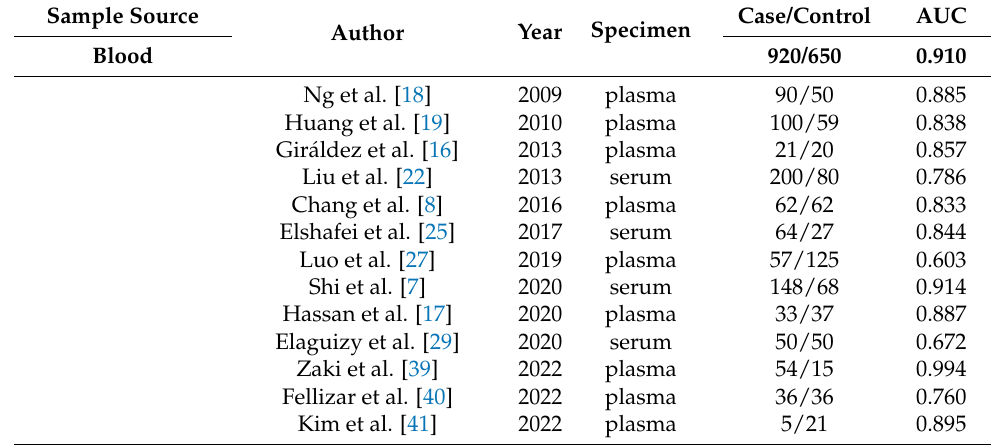
Table 2. Characteristics of included blood and stool studies in the